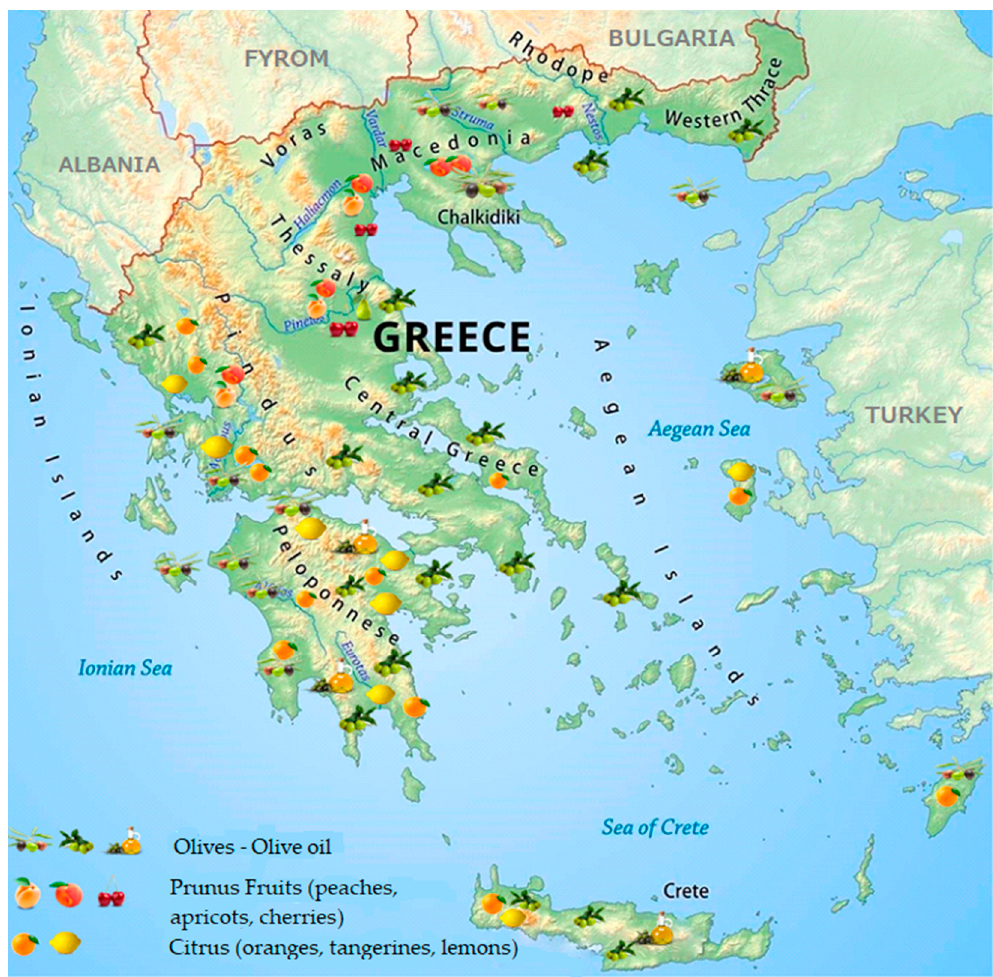
Figure 1. Geographical distribution of the major fruit tree plantations in Greece.